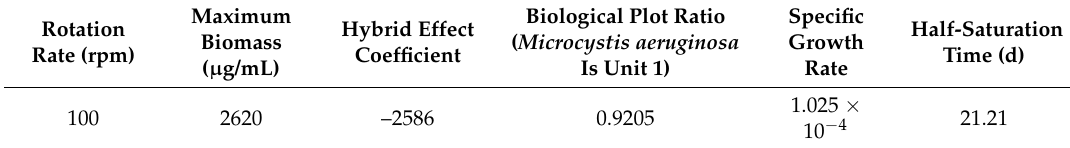
Table 3. The maximum biomass and specific growth rate under 100 rpm